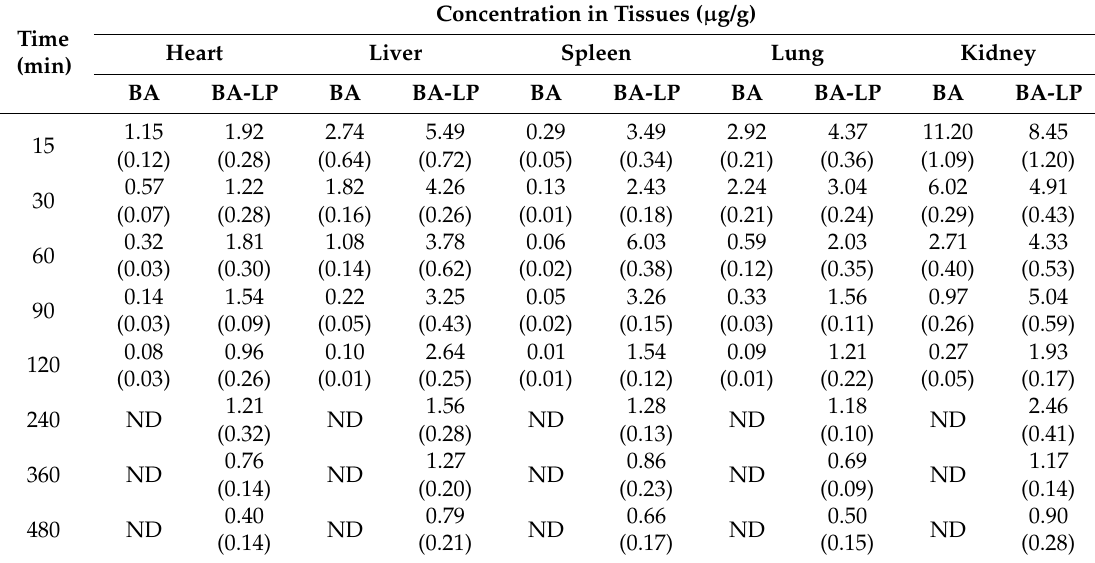
Table 5. The concentrations of BA in different tissues on MCAO models after i.v. administrated BA and BA-LP ( n = 5). Values are mean